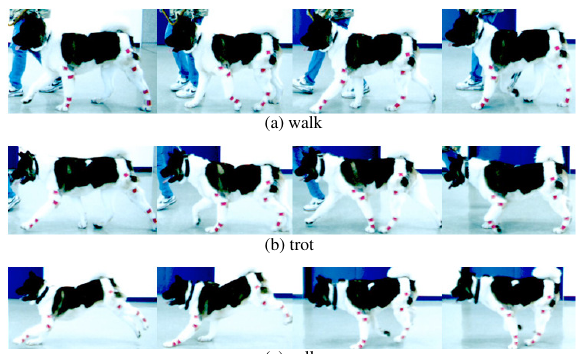
Figure 1. Observation of the gait of a dog in ( a ) the walk phase, ( b ) the trot phase, and ( c ) the gallop phase.